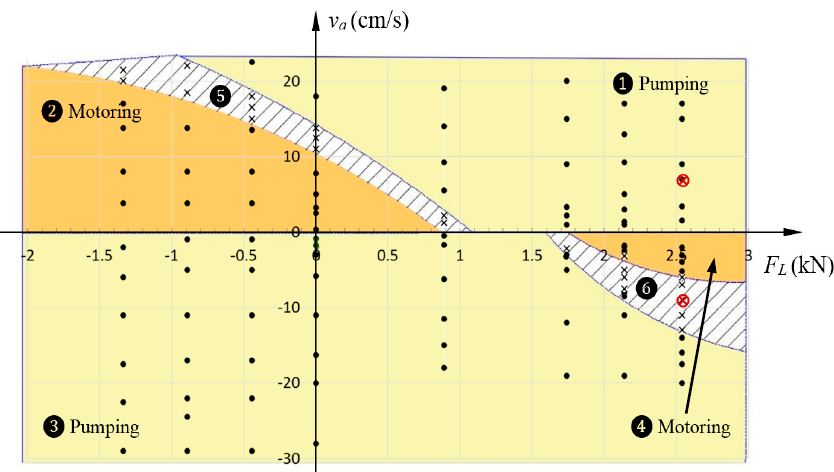
Figure 5 . Experimental identification of critical zone (shown by hashed lines) for circuits utilizing POCVs (Figure